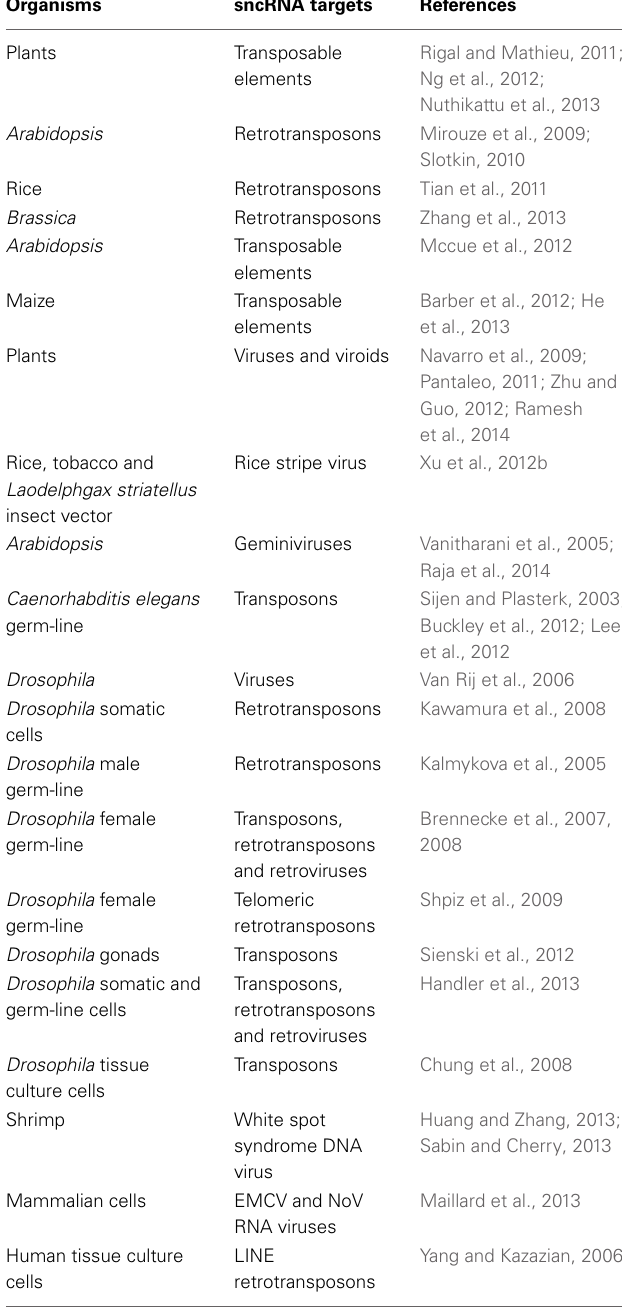
Table 1 | Genome immunity by sncRNA targeting of mobile DNA (see also http://shapiro.bsd.uchicago.edu/TableII.9.shtml for